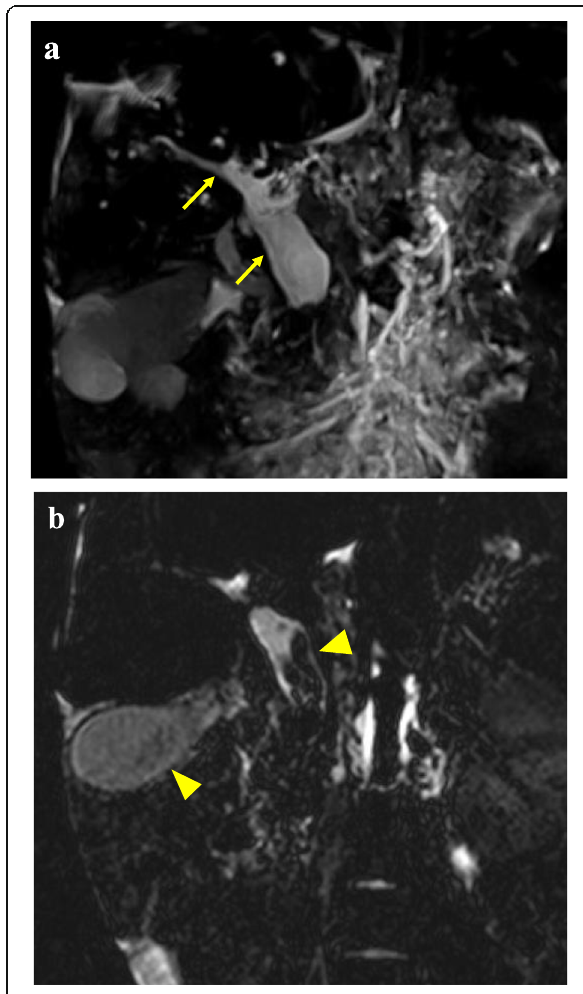
Fig. 2 Magnetic resonance cholangiopancreatography (coronal view). a The intrahepatic and extrahepatic bile ducts were dilated (arrow). b Multiple choleliths were recognized in the gallbladder and common bile duct